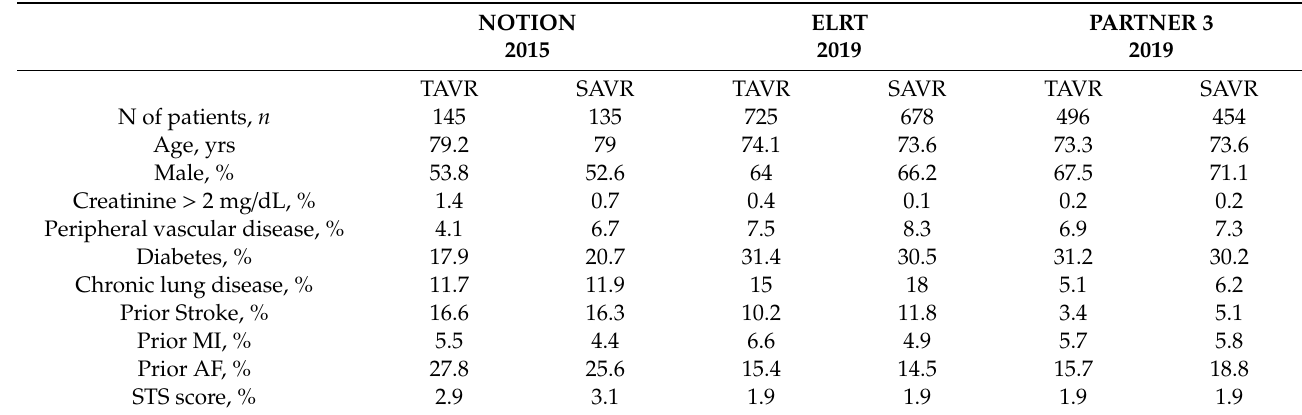
Table 2. Patient’s